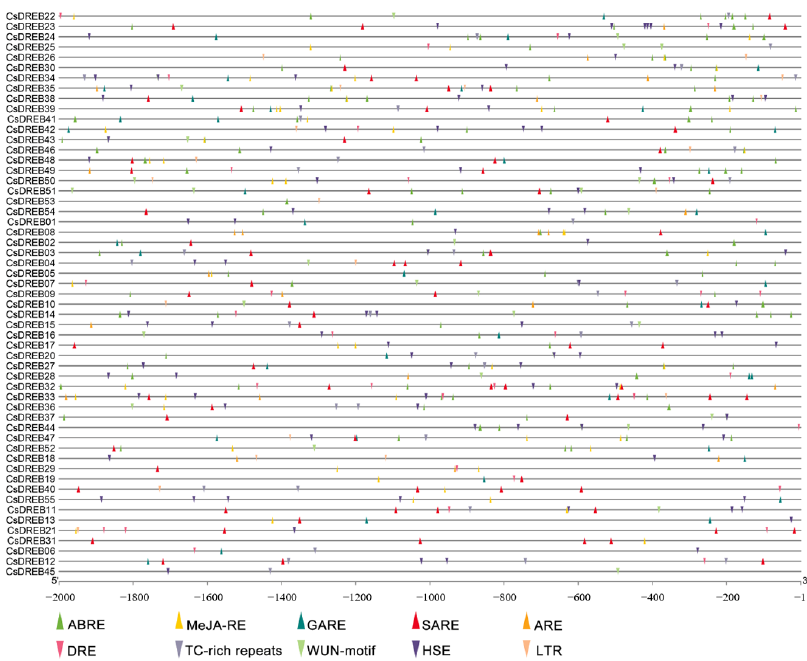
Figure 3. Analysis of phylogenetic relationships, gene structures, and motifs in cucumber: Left panel—the phylogenetic tree was constructed from the sequences of CsDREB proteins. The different groups are shown in different colors. Middle panel—different colored boxes represent the motifs of CsDREB; The details of each motif are shown in Table S4. Right panel—gene structure of CsDREB TFs; 5′- and 3′-regions, exons, and introns are indicated by green boxes, yellow boxes, and grey lines, respectively. The gray numbered line at the bottom represents gene length.